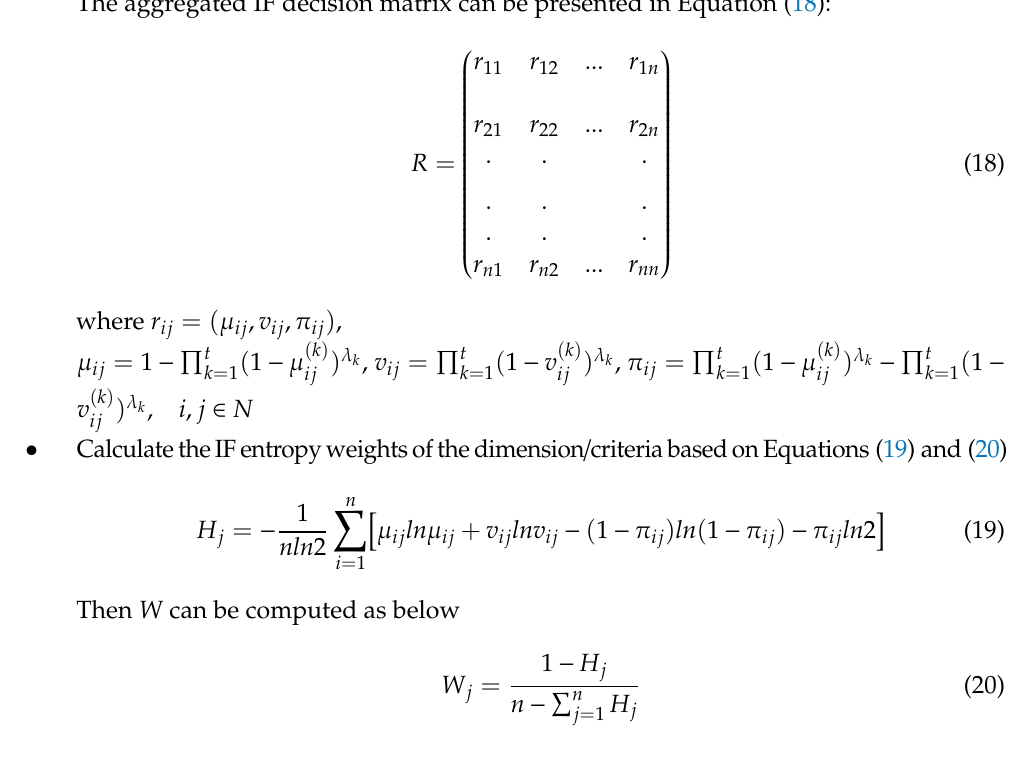
Table 4. Linguistic expressions to assess the importance weights of expert. Linguistic